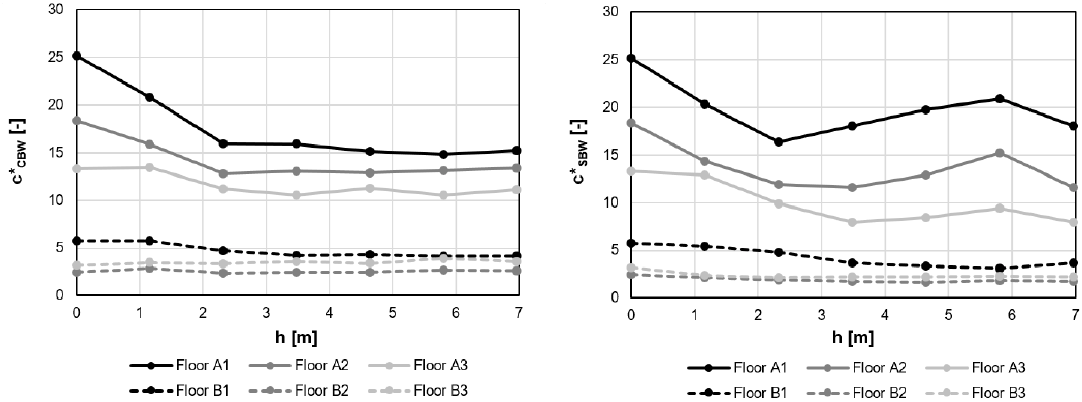
Figure 12. Area averaged normalized concentrations at the focus areas as a function of low boundary wall (LBW) height in the case of central ( left ) and sidewise ( right ) boundary walls.